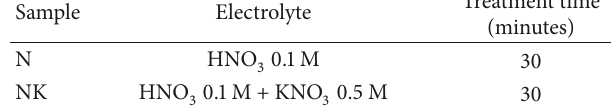
Table 1: Electrochemical nitriding conditions.